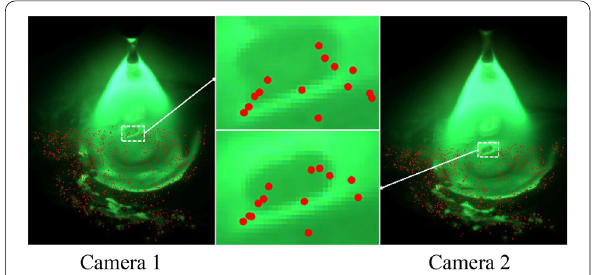
Figure 12 Matching pairs preprocessed by the data preprocessing model (240 A, 33 V, 0.6